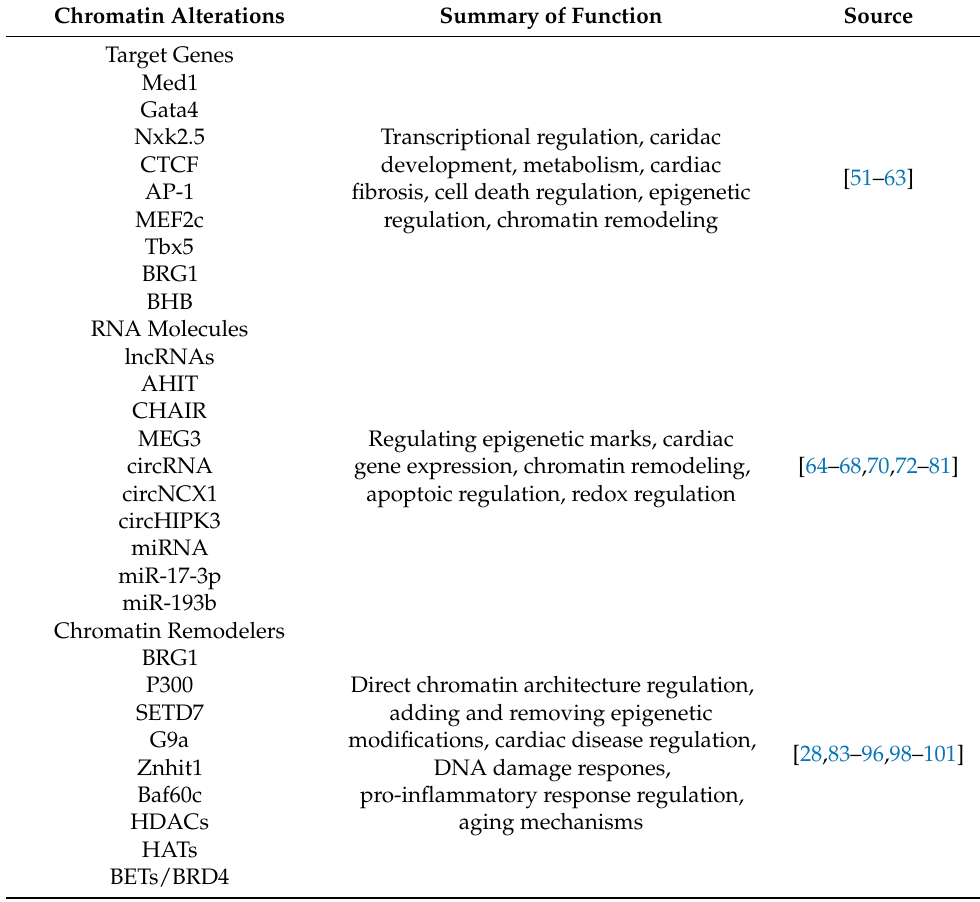
Table 1. Summary of chromatin remodeling mechanisms during heart